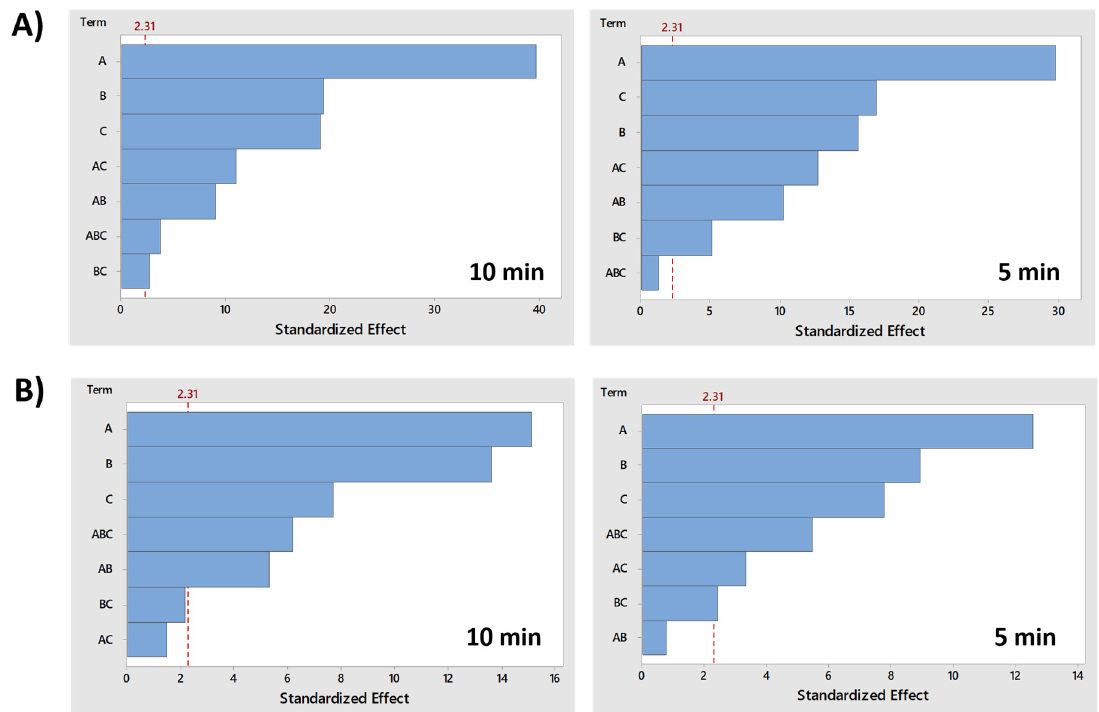
Figure 8. Pareto chart of standardized effects ( α = 0.05) for MB discoloration after 10 and 5 min under ( A ) UV-A radiation; ( B ) UV-C radiation. Factor names: A = PMS; B = TiO 2 ; C = Fe 2+ .